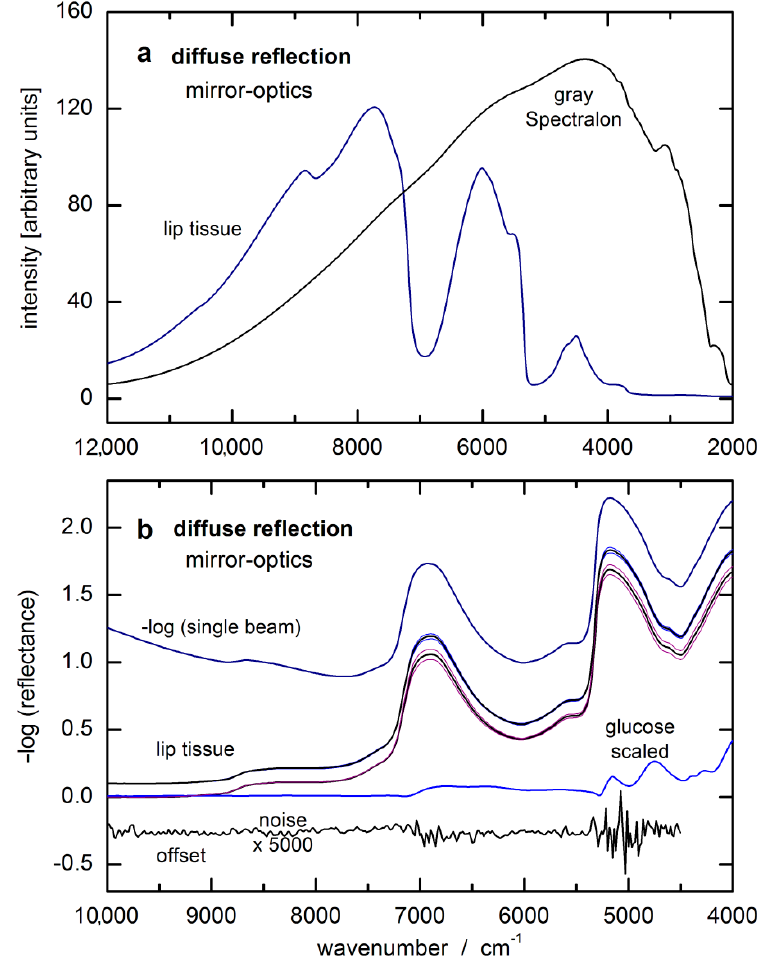
Figure 3. ( a ) Single-beam spectra of oral mucosa and a gray reflectance standard of 5% reflectivity, measured by diffuse reflection; ( b ) log-converted single-beam lip spectrum and two lip reflectance spectra as calculated from two respective series of five consecutively recorded lip tissue spectra shown as average spectra with according standard deviation spectra (spectra were taken at the beginning of our two-day measurements with capillary blood glucose values around 50 mg/dL and around 400 mg/dL during the first day; all spectra were offset for better visualization) and enlarged noise spectrum from two consecutive lip measurements after baseline correction.